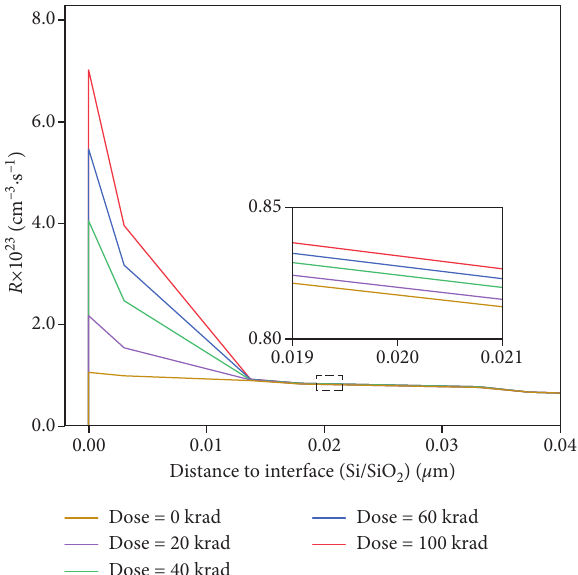
Figure 10: Synergistic effects of NPN transistors at different